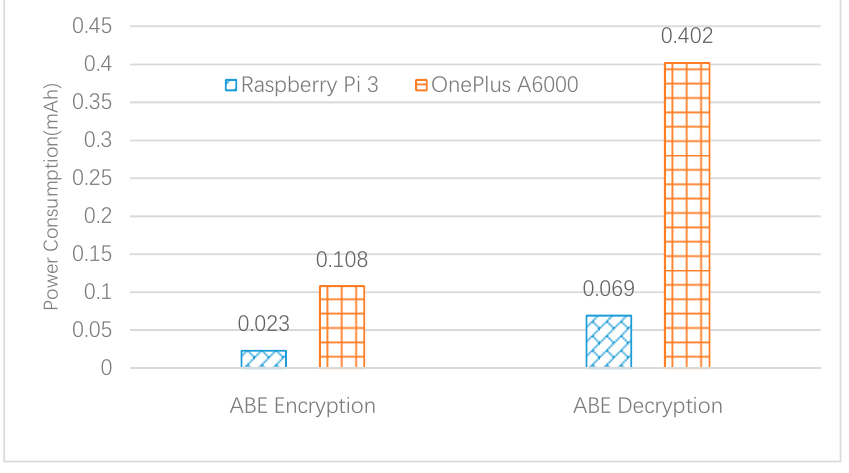
Figure 14. Hybrid ABE algorithms’ energy consumption on Raspberry Pi 3 and OnePlus A6000 smartphone (1 KB plaintext).